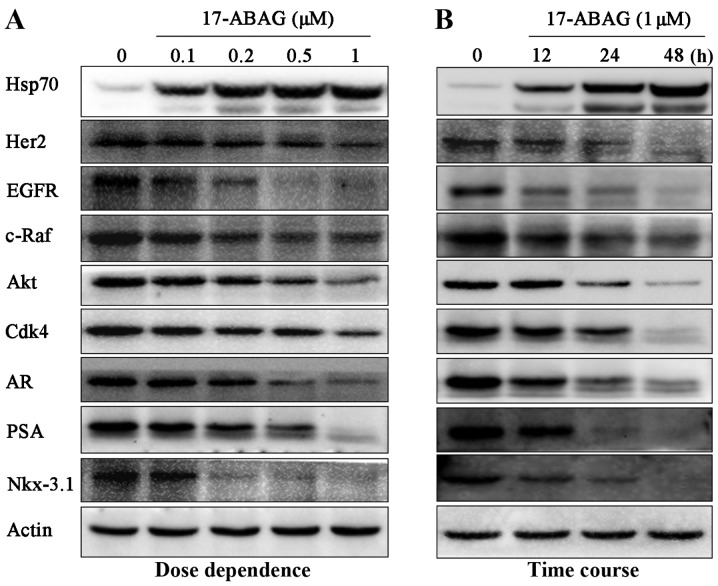
17-ABAG induces the degradation of Hsp90 client proteins. (A) LNCaP cells were cultured in the presence of 17-ABAG at the indicated concentrations for 24 h, and the proteins regulated by Hsp90 or ARs were assessed by western blot analysis. β-actin was used for normalization and verification of protein loading. (B) LNCaP cells were treated with 1 μM 17-ABAG for the indicated times and the proteins regulated by Hsp90 or ARs were assessed by western blot analysis. β-actin was used for normalization and verification of protein loading. HSP, heat shock protein; AR, androgen receptor; PSA, prostate-specific antigen; EGFR, epidermal growth factor receptor; Cdk4, cyclin-dependent kinase 4; Her2, human epidermal growth factor receptor 2; Nkx-3.1, Nk3 homeobox 1.